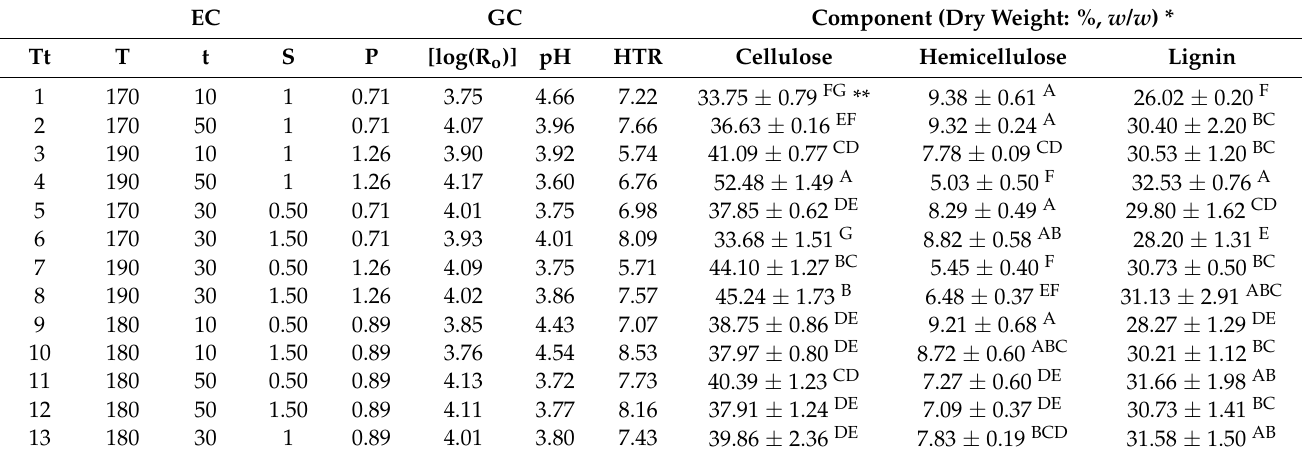
Table 3. Solid phase composition after hydrothermal processing.